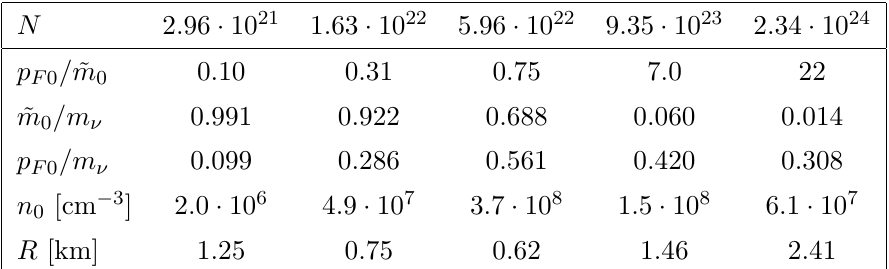
Table 1 . Characteristics of final (degenerate) states of neutrino clusters for y = 10 − 7 and m φ = 0 .